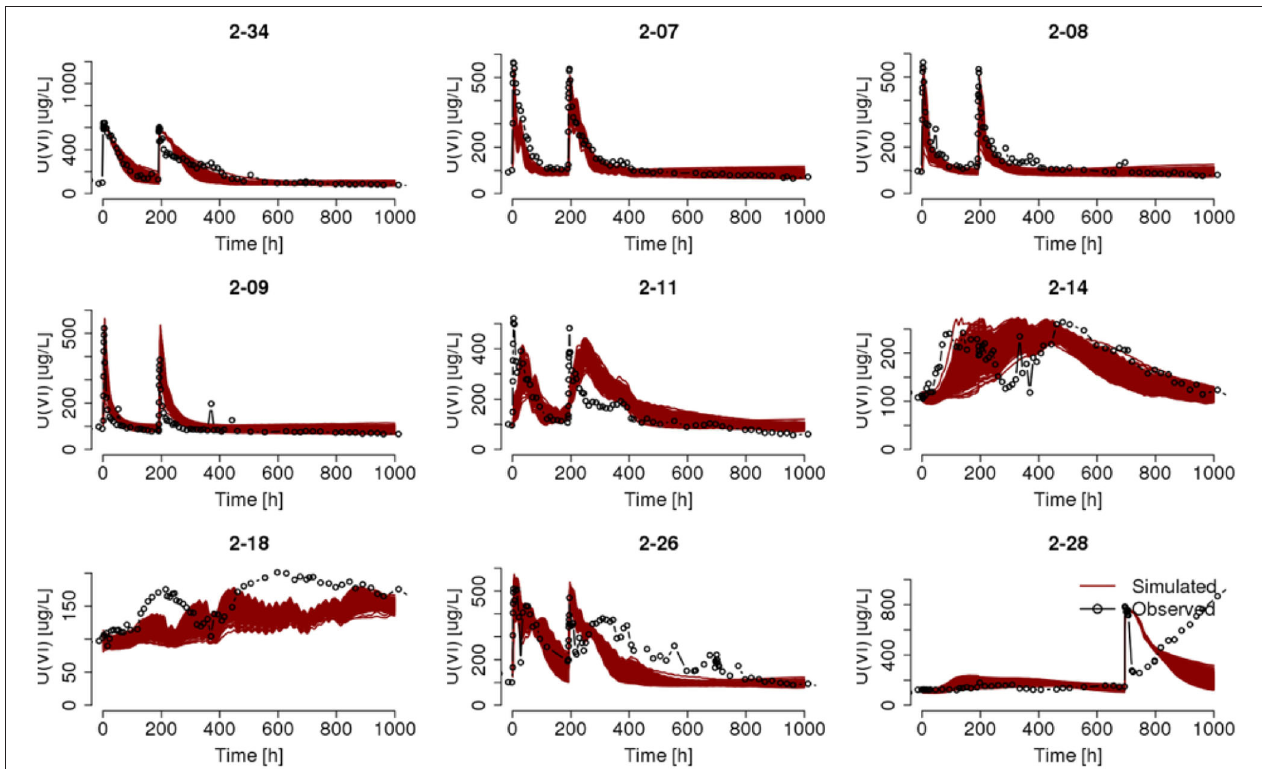
FIGURE 8 | Ensemble of predicted uranium breakthrough curves in selected wells after scaling the sorption site concentration by a factor of one-tenth. Other plotting specifics are the same as Figure 7 .